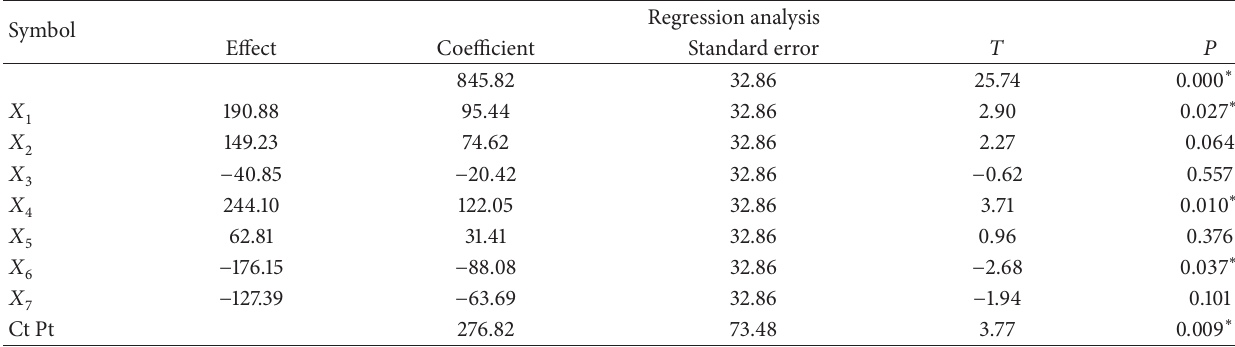
Table 5: Results of regression analysis of Plackett-Burman design. Symbol